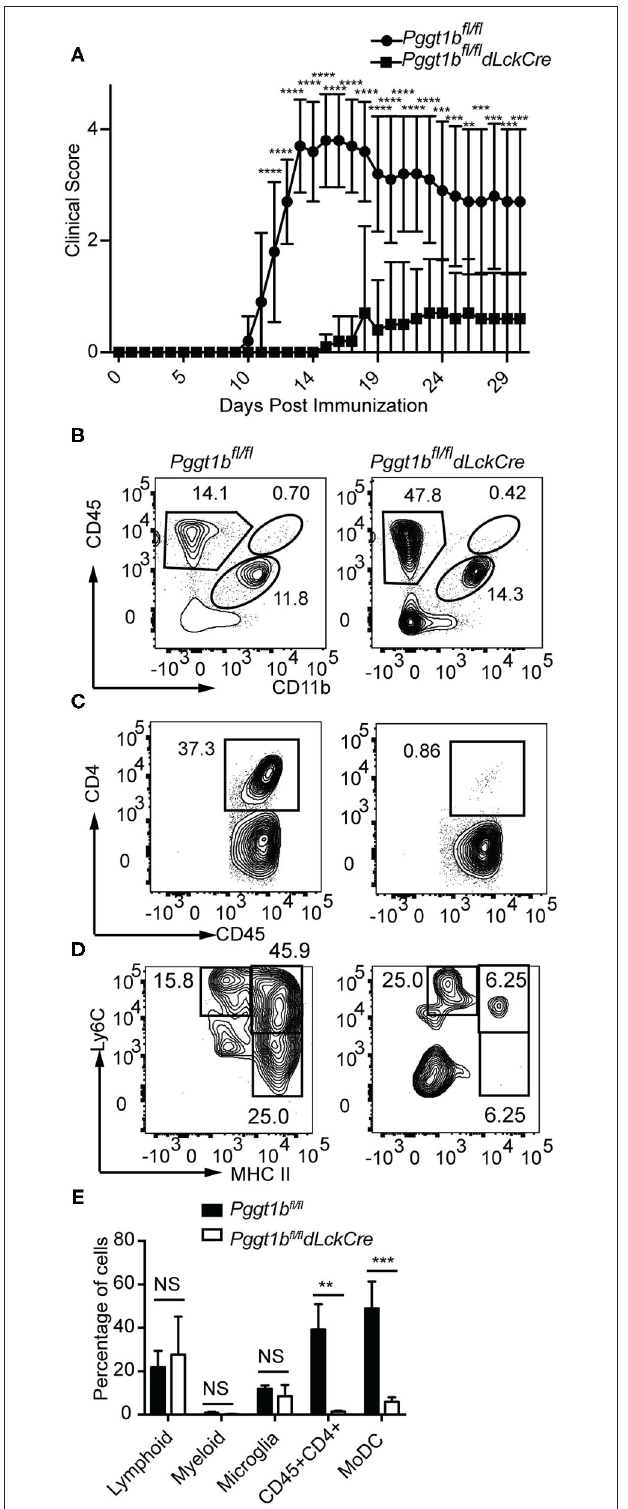
FIGURE 5 | Pggt1b fl / fl dLckCre mice are resistant to EAE induction. (A) Clinical scores of mice immunized with MOG35-55 peptide emulsified in complete Freud’s adjuvant; (B–D) Flow cytometry analysis of spinal cords